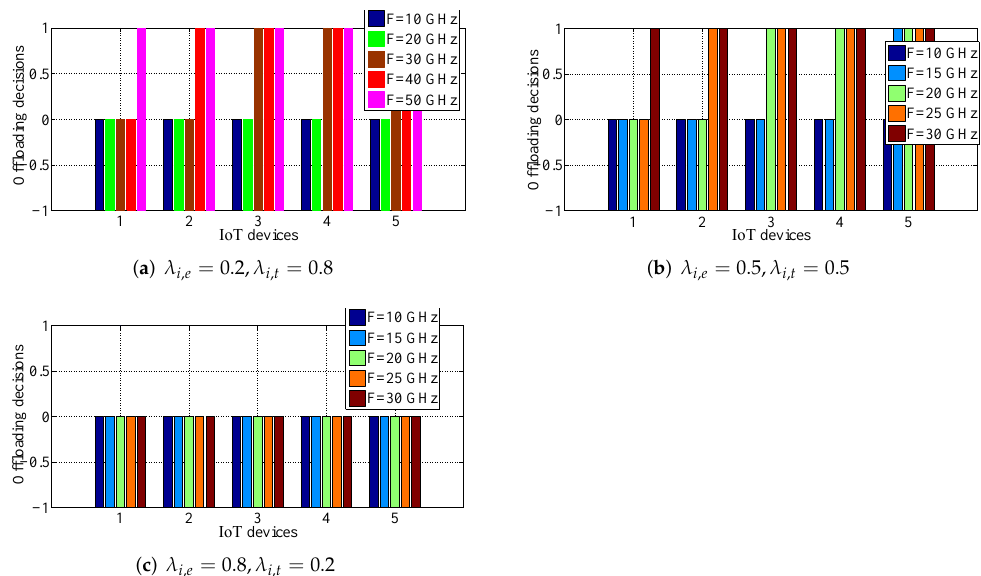
Figure 4. The effect of the edge cloud capacity on the offloading decisions. Figure 5a,b depict how the edge cloud capacity affects the application completion time under different values of weight coefficient. We see that the application completion time for each IoT device will decrease if the edge cloud capacity increases. By comparing Figure 5a,b, we find that the application completion time for each IoT device in Figure 5b is smaller than that in the Figure 5a under fixed edge cloud capacity. This is owing to the fact that the coefficient value of λ i , t is smaller in Figure 5a.